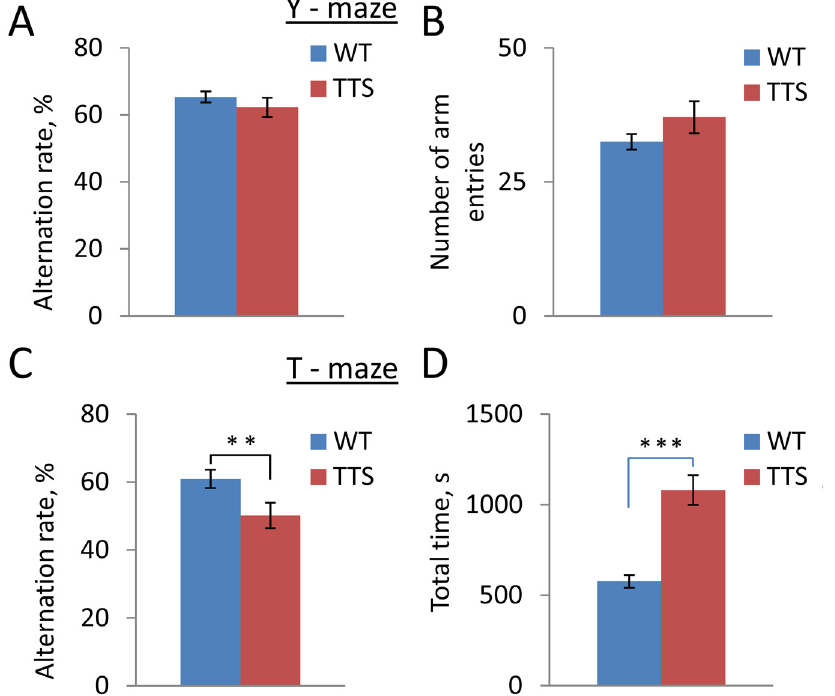
Fig 4. Working memory. A: Alternation rate in Y-maze; B: Number of arm entries in Y-maze; C: Alternation rate in T-maze; D: Averaged time spent on T-maze test. Mean ± SEM. Number of tested animals WT = 22; TTS = 12. ** p < 0.01 and *** p < 0.001, significantly different from WT